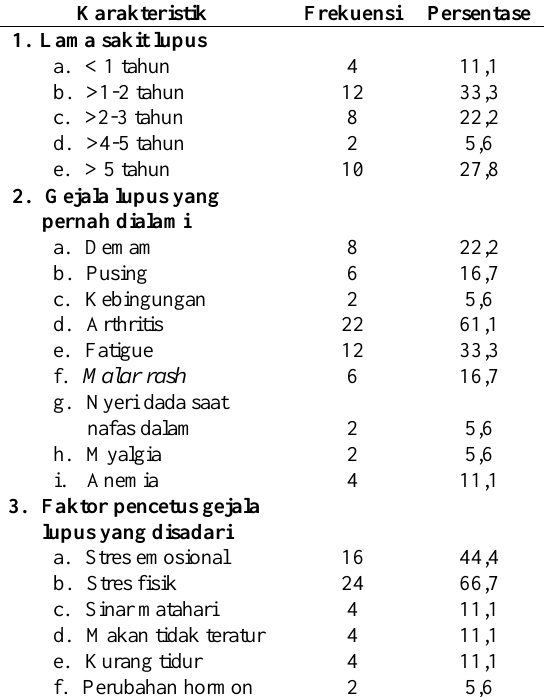
Tabel 3. Data Primer